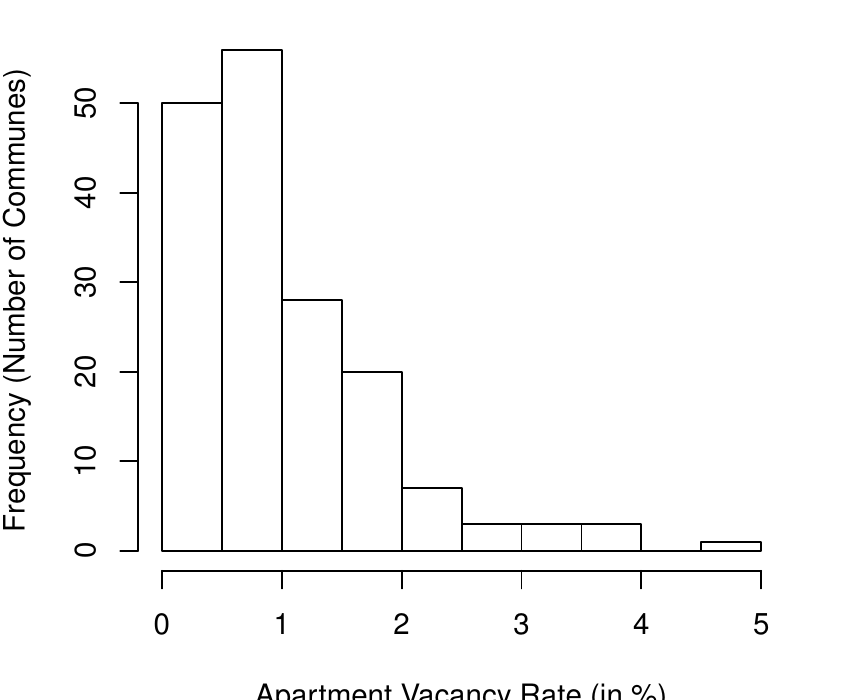
Figure A2. Apartment vacancy rates. (This figure illustrates the apartment vacancy rate across municipalities in the canton of Zurich. Out of 171 municipalities, more than half have an apartment vacancy rate of less than 1%. Overall, the average is 0.61%).